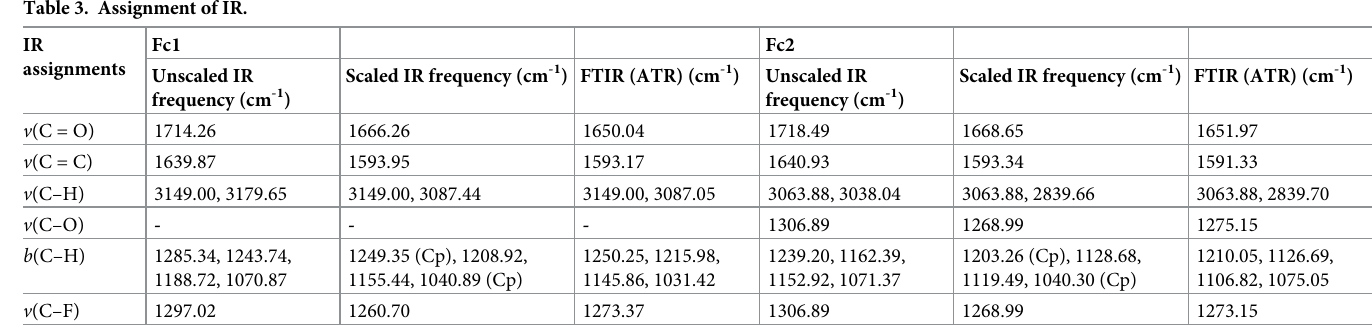
Table 3. Assignment of